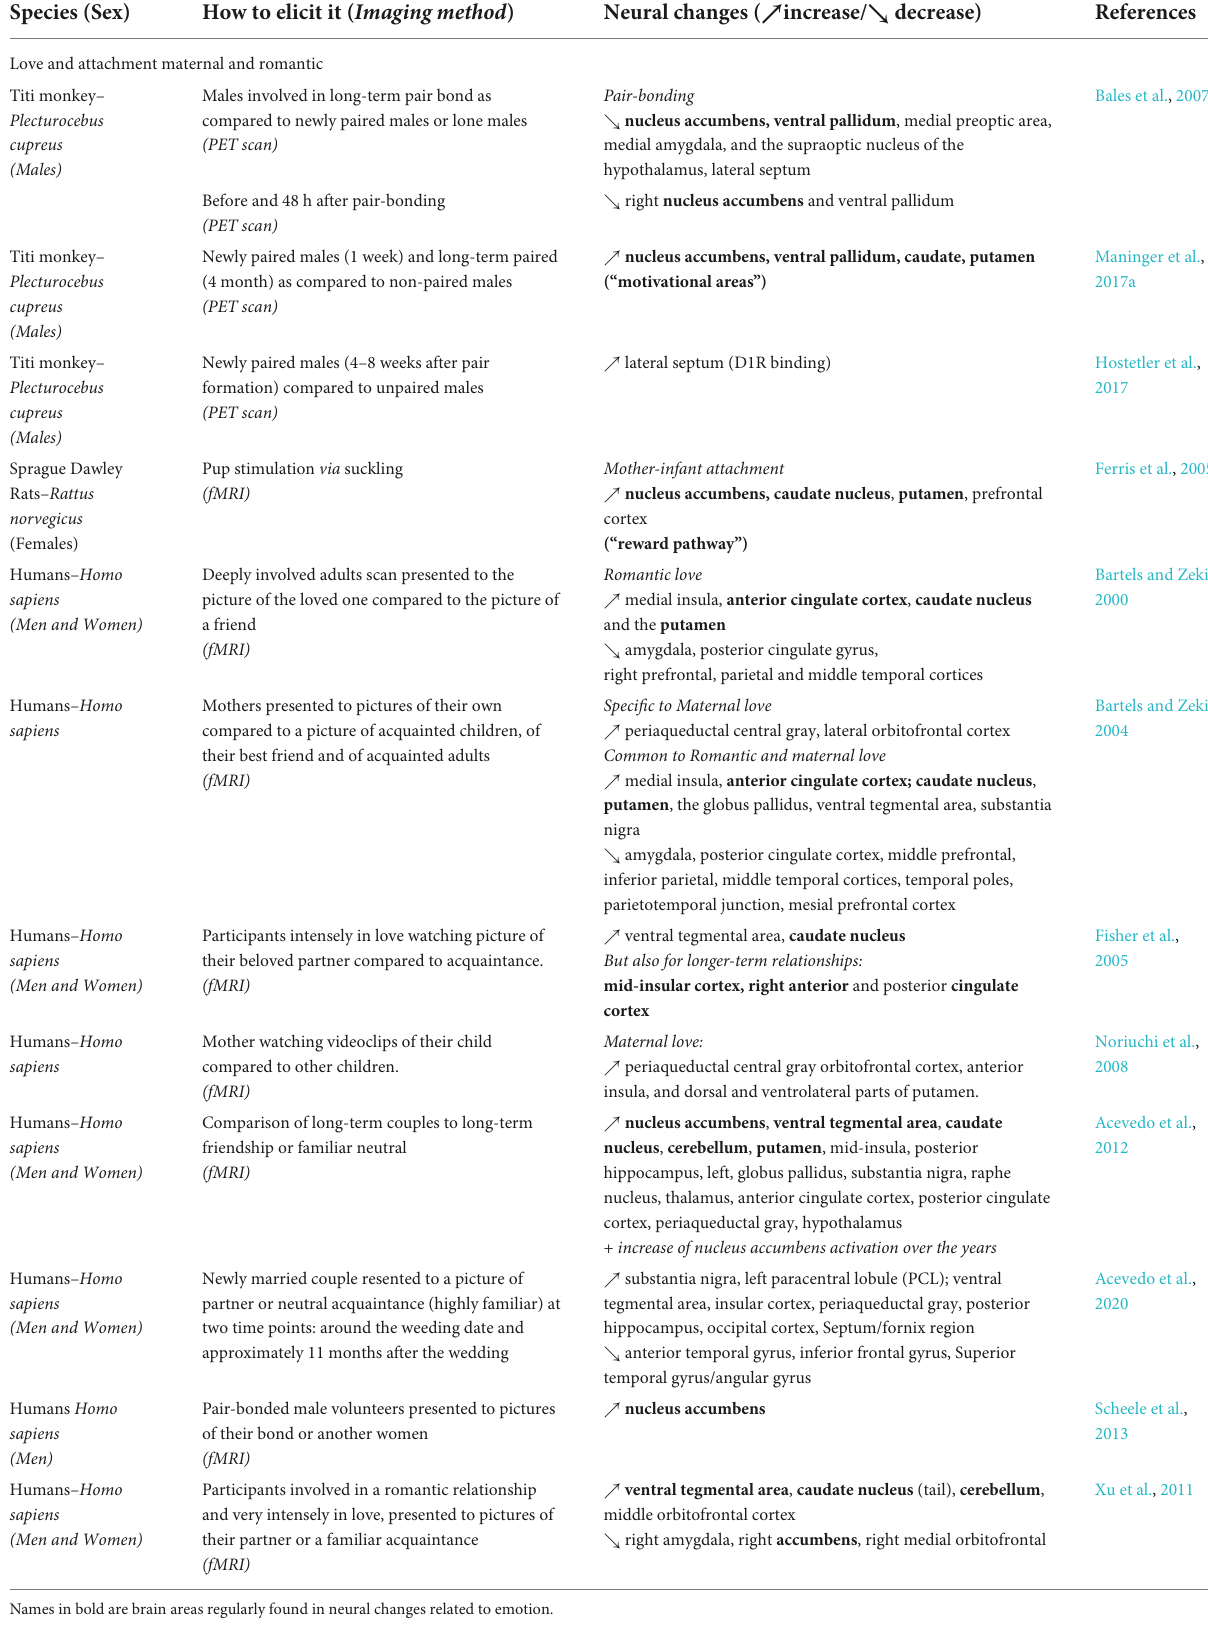
TABLE 2 Summary of the brain areas involved in the expression of “love” across species. Species